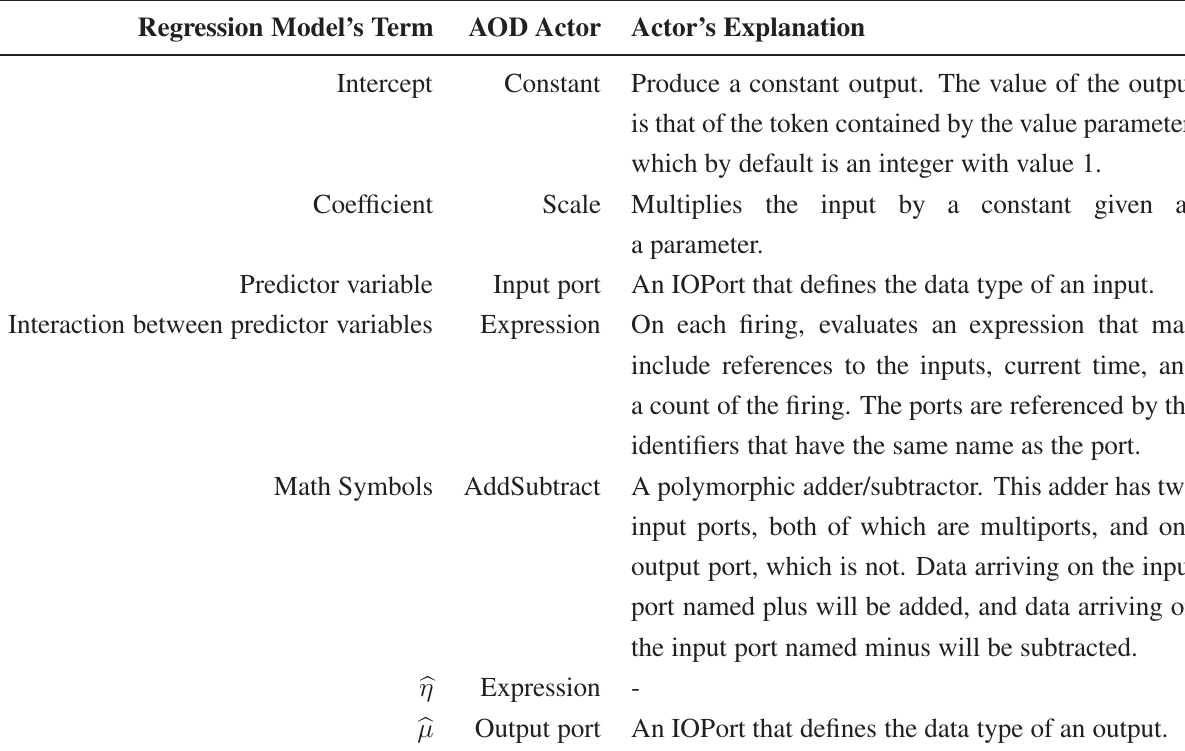
Table 2. Mapping from Regression Model to AOD